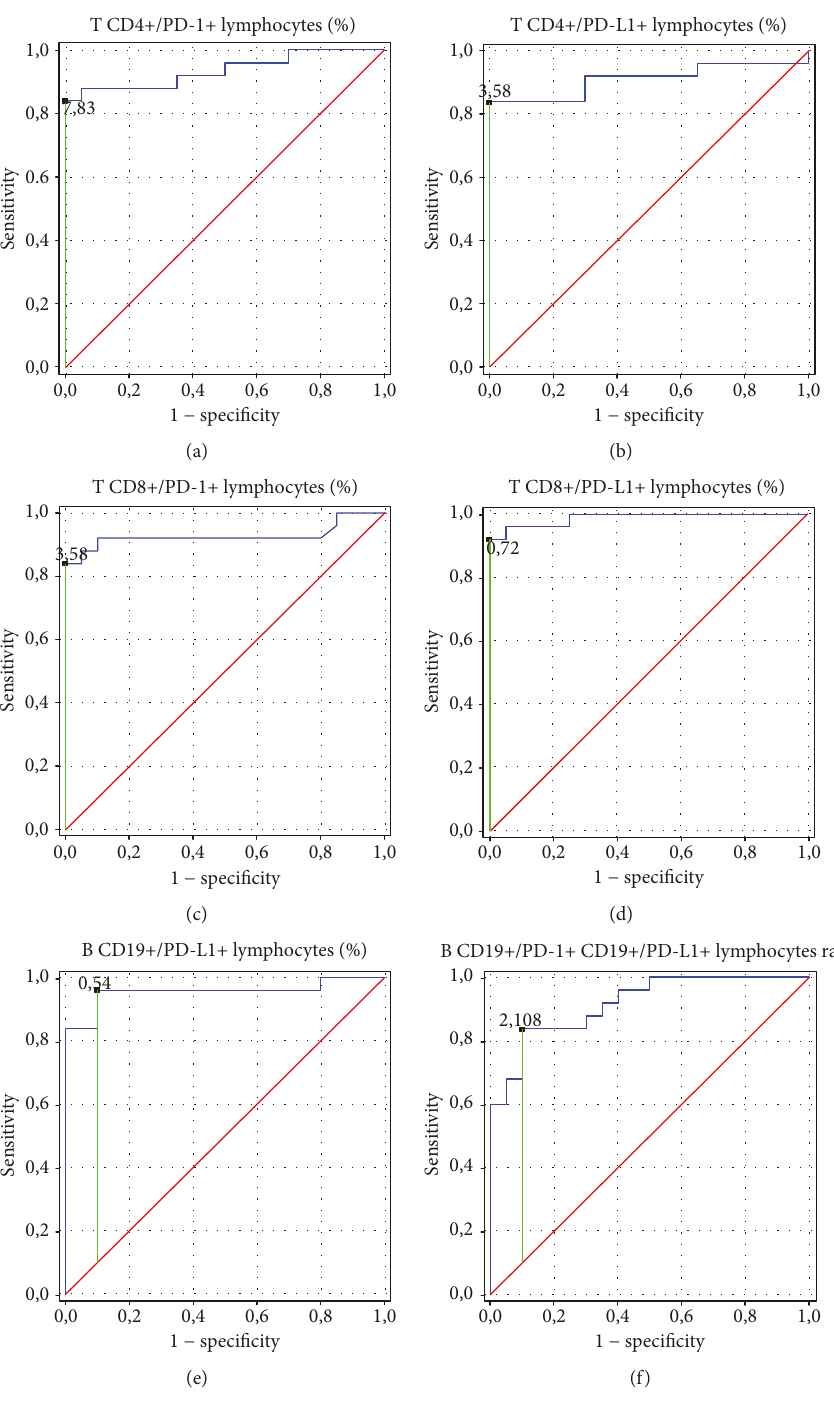
Figure 3: Receiver operating characteristic (ROC) curve to compare immunological parameter sensitivity and speci fi city in patients with endometriosis. (a) ROC curves of CD4 + /PD-1 + lymphocytes (%). (b) ROC curves of CD4 + /PD-L1 + lymphocytes (%). (c) ROC curves of CD8 + /PD-1 + lymphocytes (%). (d) ROC curves of CD8 + /PD-L1 + lymphocytes (%). (e) ROC curves of CD19 + /PD-L1 + lymphocytes (%). (f) ROC curves of CD19 + /PD-1 + lymphocytes: CD19 + /PD-L1 + lymphocyte